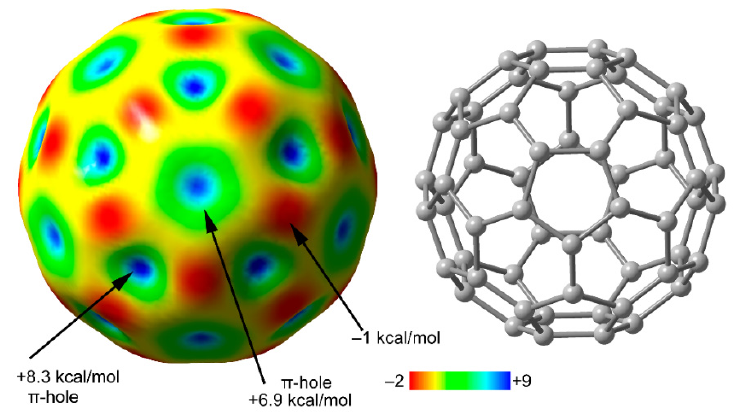
Figure 12. (Left ) MEP surface of C 60 at the B3LYP / 6-31 + G* (isosurface 0.001 a.u.); ( Right ) The C 60 is represented using the same orientation utilized to plot the MEP surface.